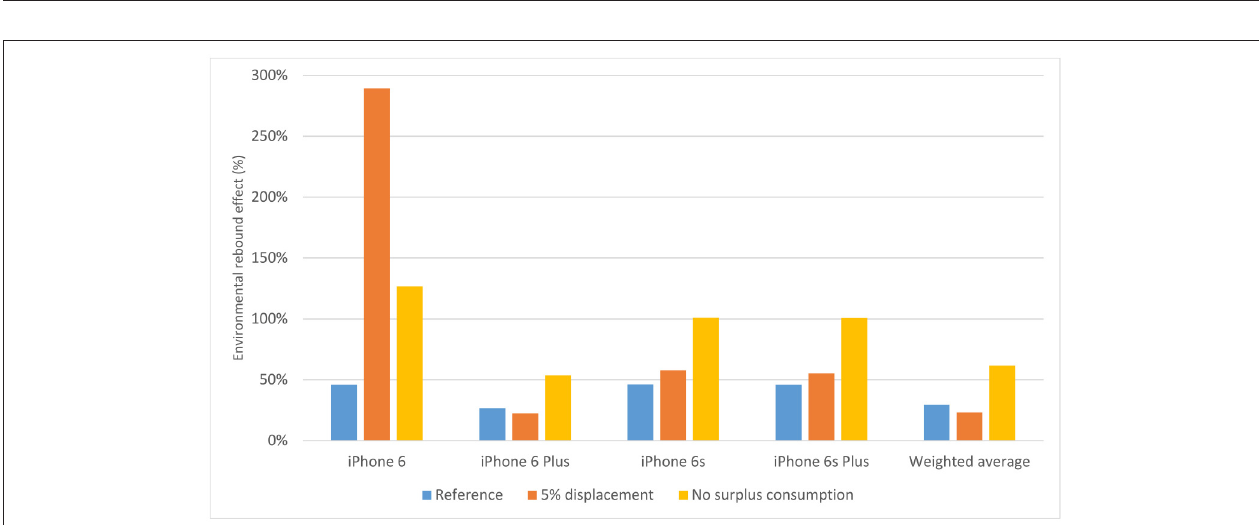
FIGURE 3 | Environmental rebound effect (ERE) magnitude of reusing a smartphone for selected iPhone models and scenarios with imperfect substitution. The “average” model corresponds to a weighted average of all four iPhone models by their eBay sales volume. The ERE is expressed as the % of avoided GHG emission that are offset due to